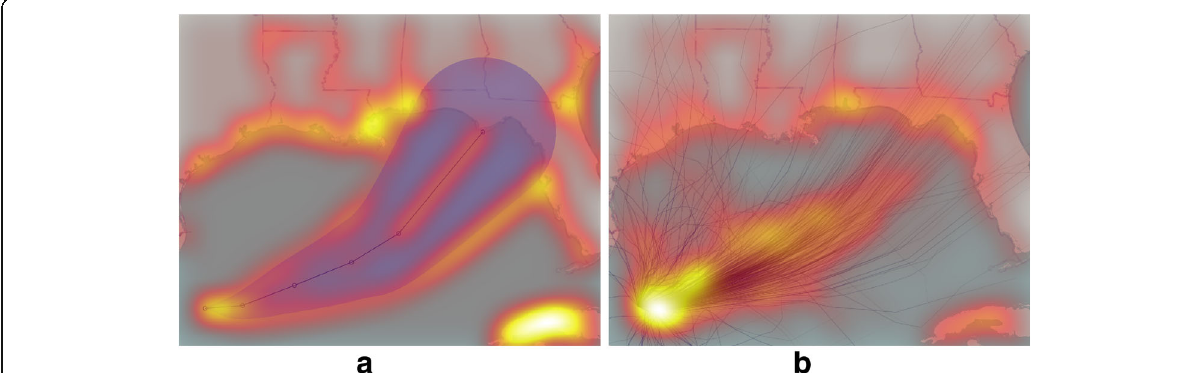
Fig. 5 Example of the visual output generated using the Itti et al. (1998) salience model, which shows example stimuli used in this experiment. Brighter coloration indicates increased salience. a The summary display. b The ensemble